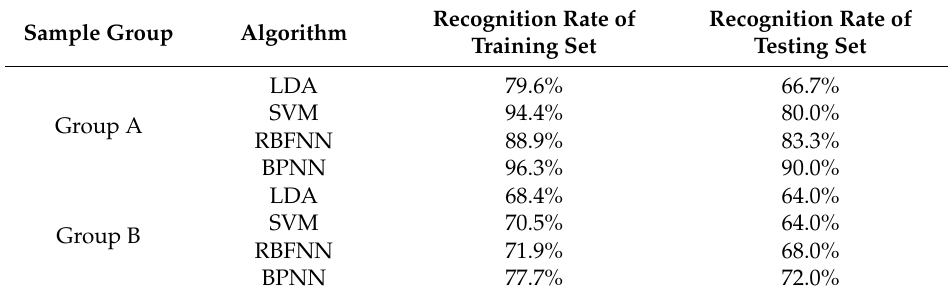
Table 3. Recognition accuracies of the four algorithms for the two groups of apples. Sample